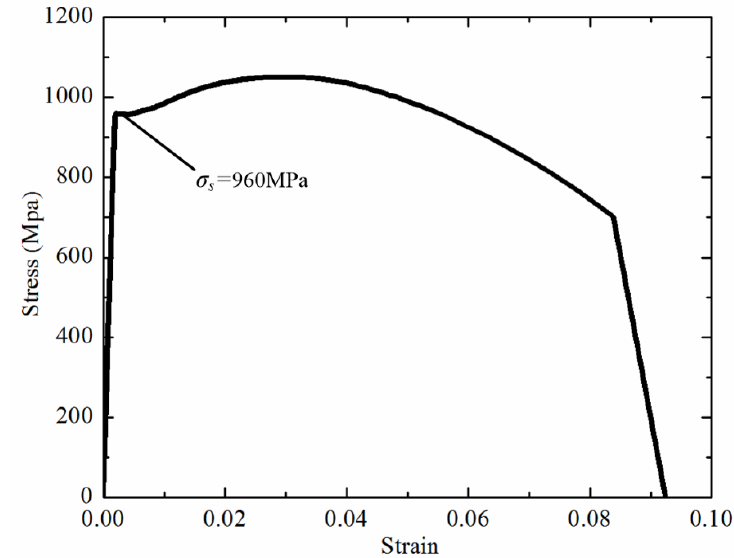
Figure 3. Tensile curve of